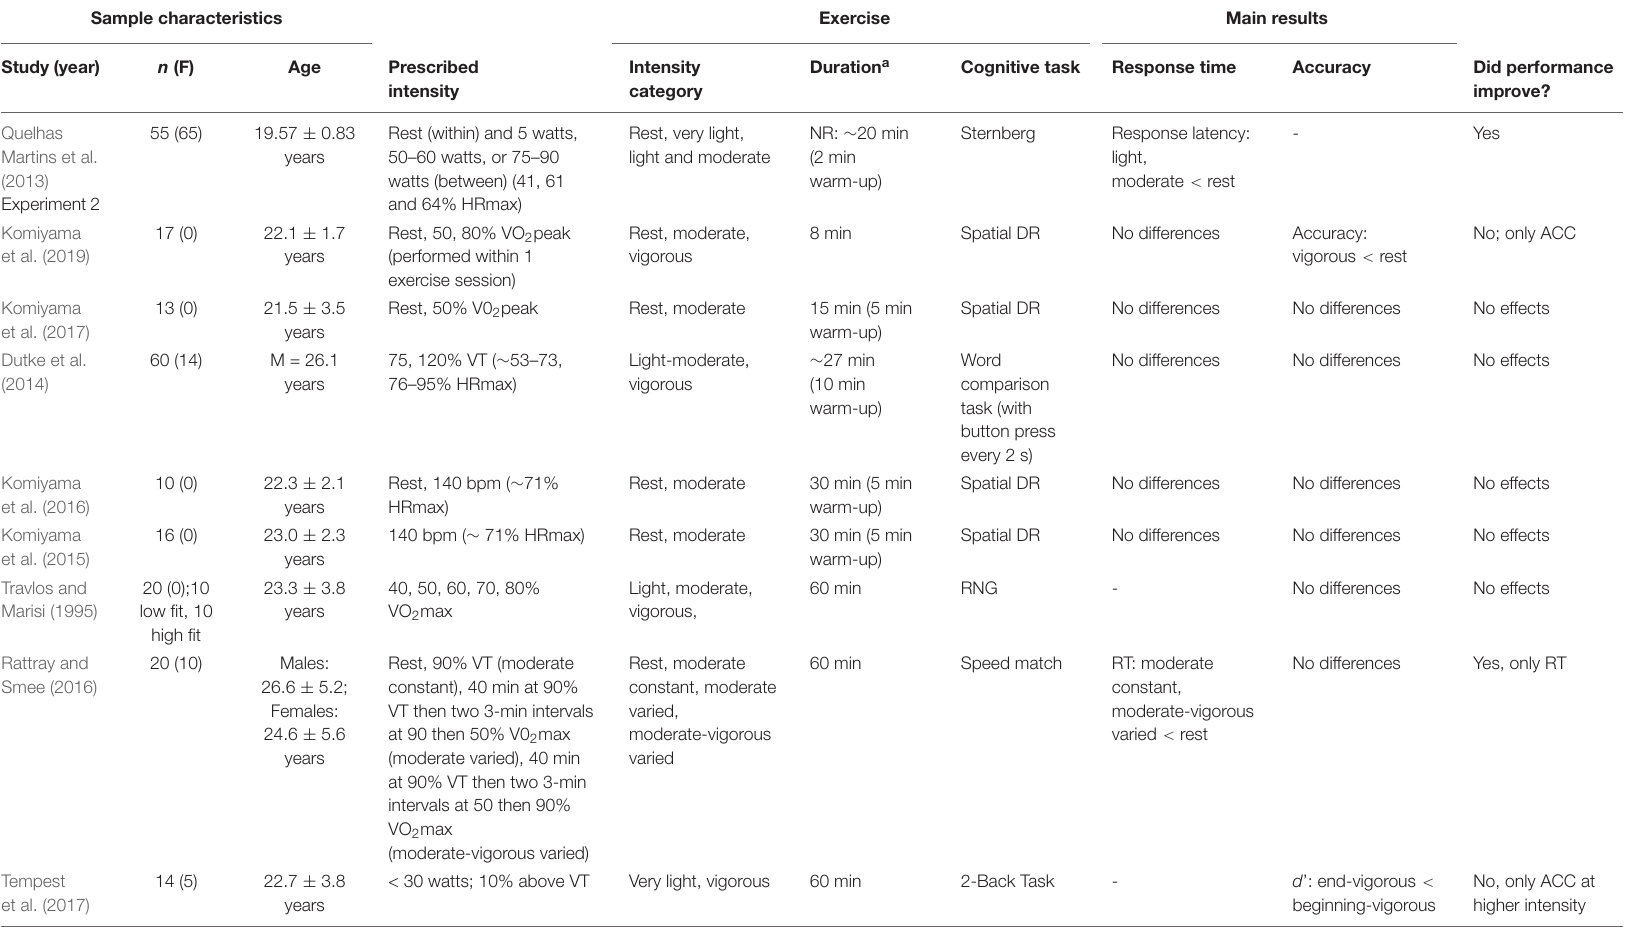
TABLE 2 | Summary of studies examining working memory during acute aerobic